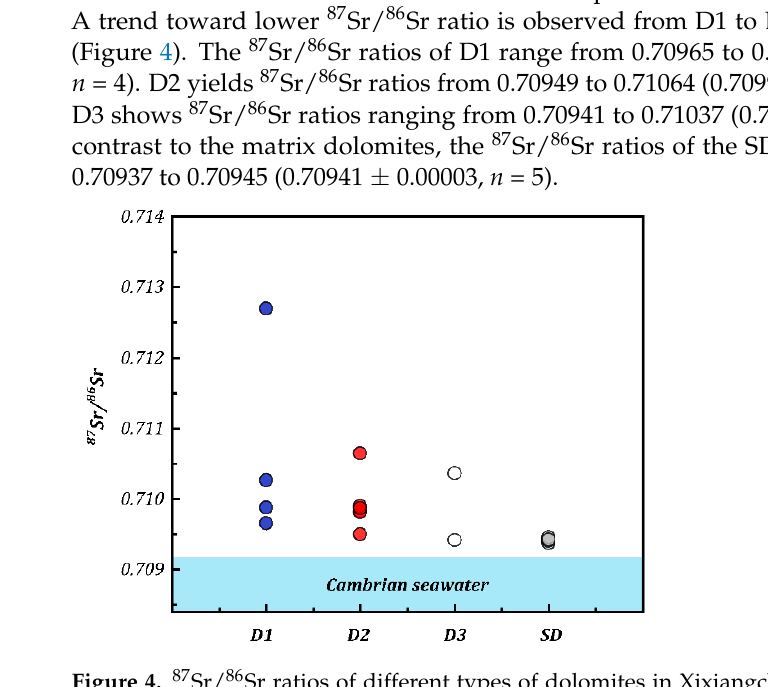
Figure 4. 87 Sr/ 86 Sr ratios of different types of dolomites in Xixiangchi Formation. The 87 Sr/ 86 Sr ratios of the Cambrian seawater are from [47].